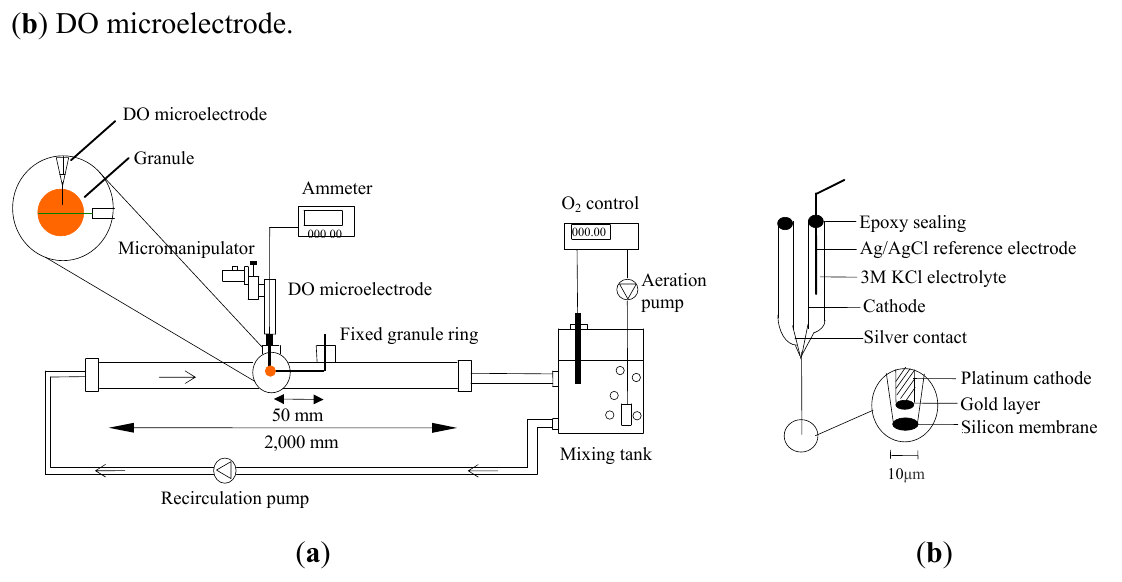
Figure 1. ( a ) Schematic diagram of the DO microelectrode measurement system; ( b ) DO